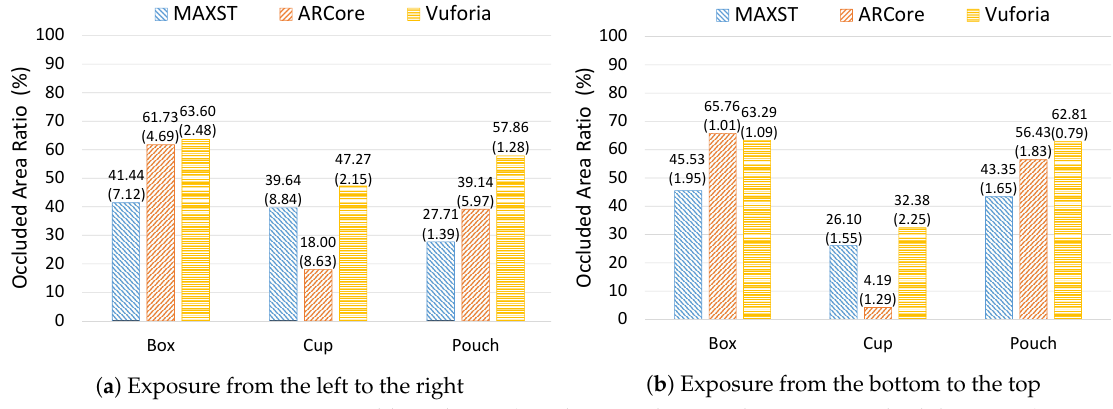
Figure 7. Maximum recognizable occlusion (numbers inside parentheses are standard deviations).